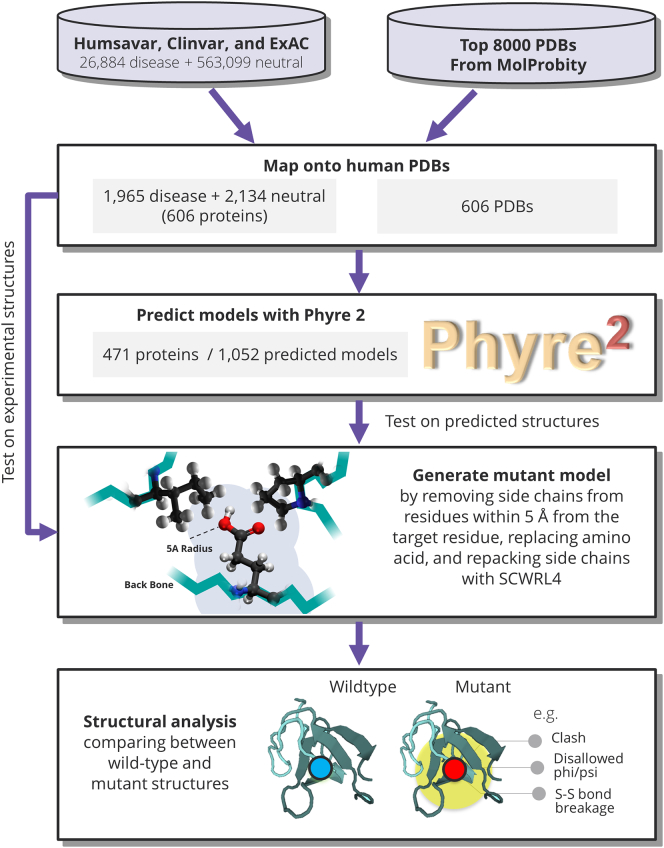
Pipeline to analyze the structural impact of missense variants in experimental and predicted structures.